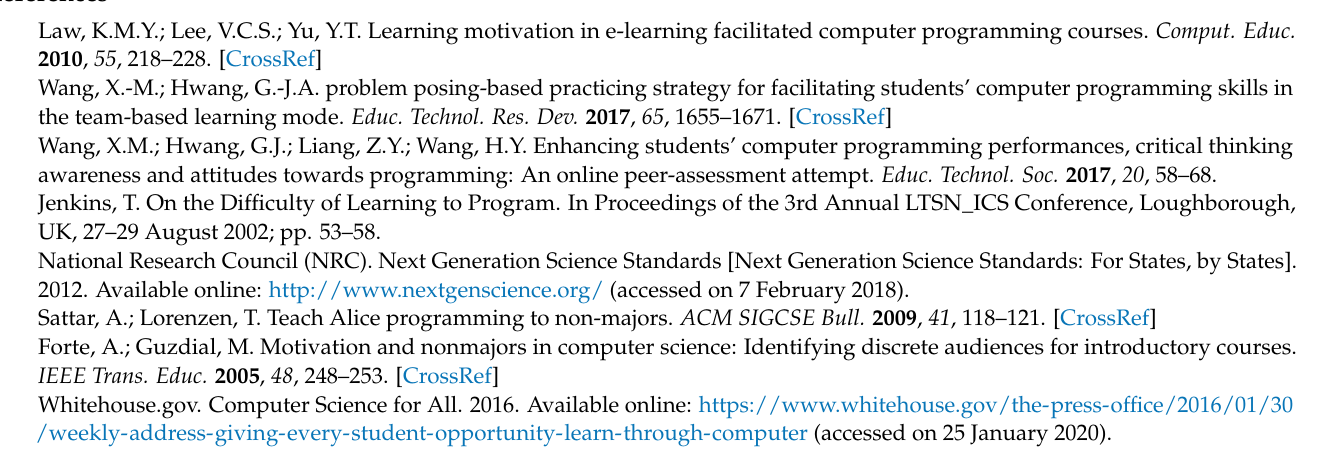
Figure A3. Final confirmatory factor analysis of PES.